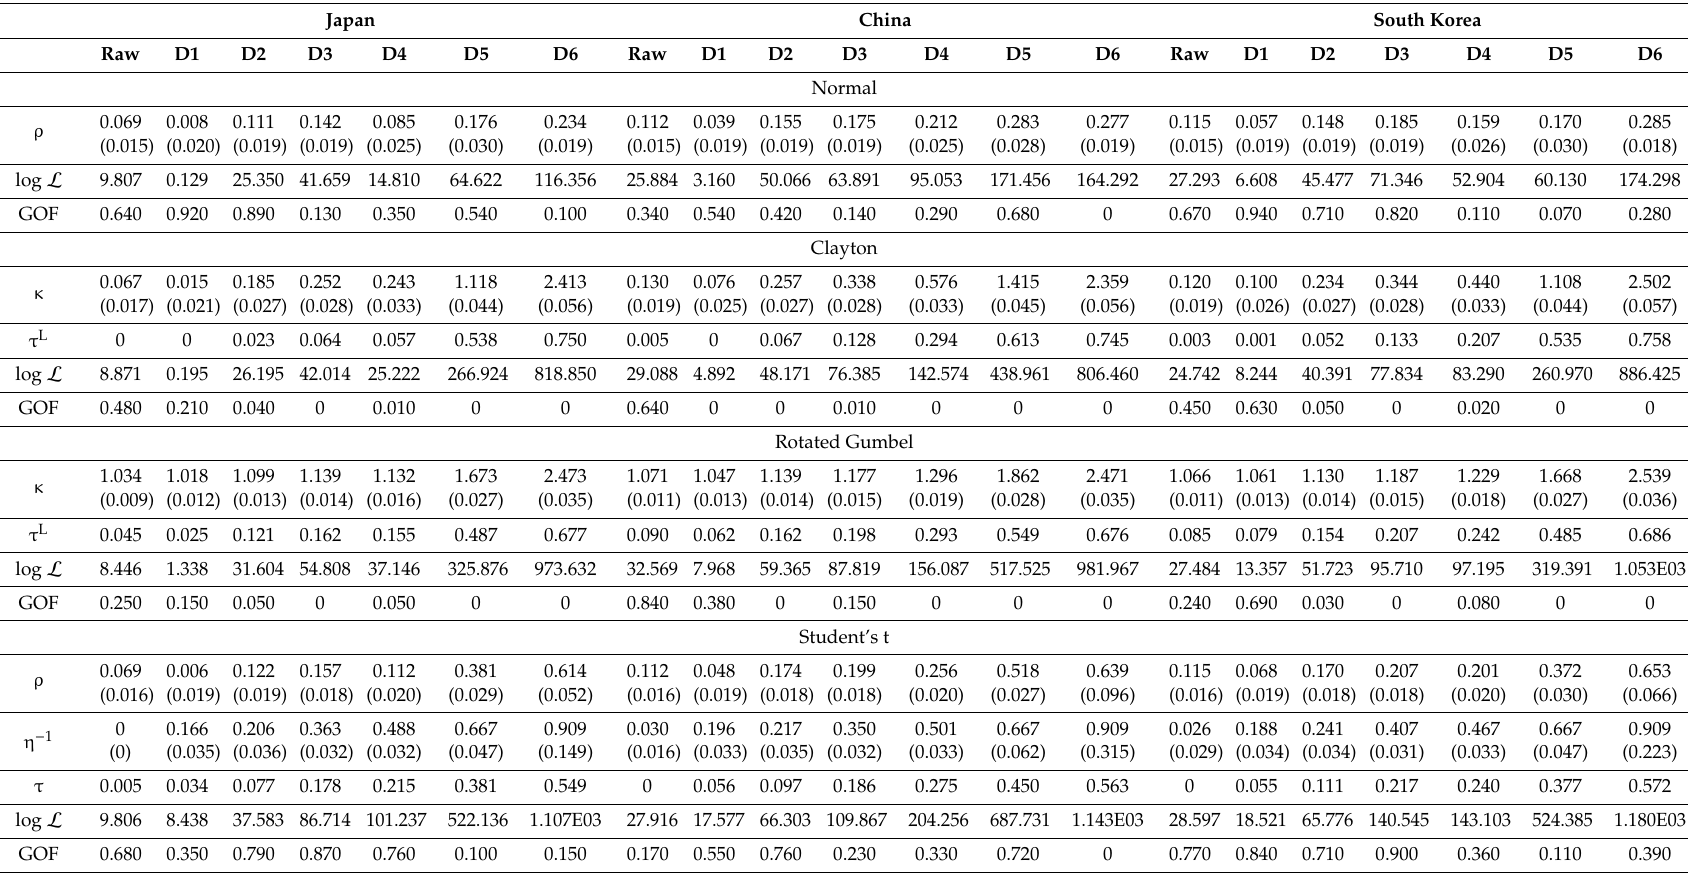
Table 3. Constant copula estimates of crude oil with East Asian stock market across multiple